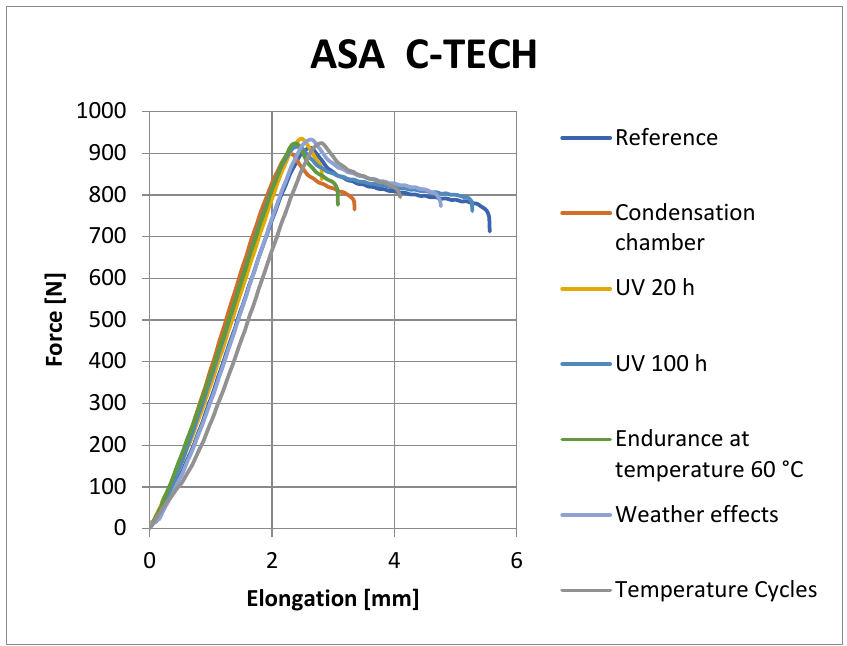
Figure 11. Tensile curves of ASA C-TECH samples.